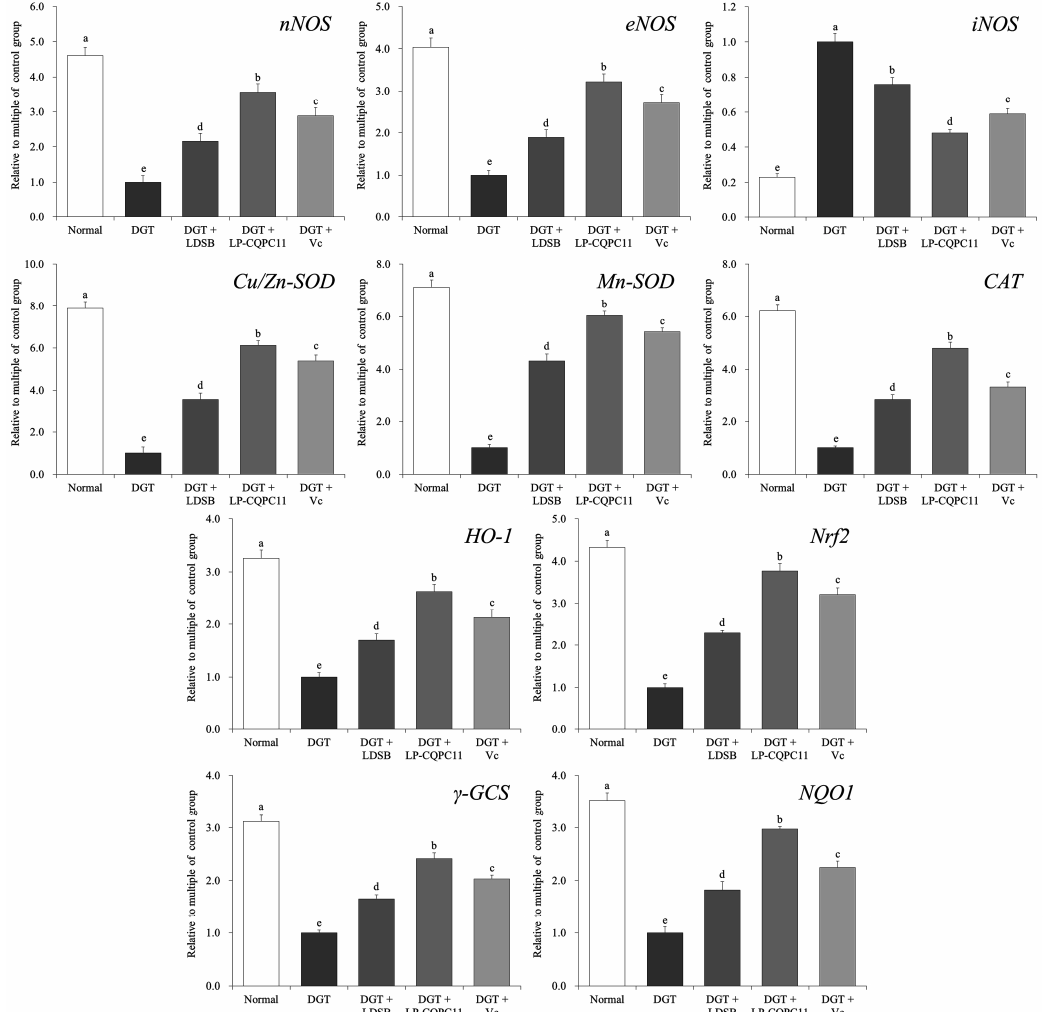
Figure 4. The mRNA expression in liver of mice. a–e The different letters mean that there are significant differences ( p < 0.05) between every two groups according to Duncan’s multiple range test. DGT: mice treated with D -galactose; DGT + LDSB: mice treated with D -galactose and Lactobacillus delbruechii subsp. bulgaricus (1.0 × 10 9 CFU/kg); DGT + LP-CQPC11: mice treated with D -galactose and Lactobacillus plantarum CQPC11 (1.0 × 10 9 CFU/kg); DGT + Vc: mice treated with D -galactose and vitamin C (200 mg/kg).